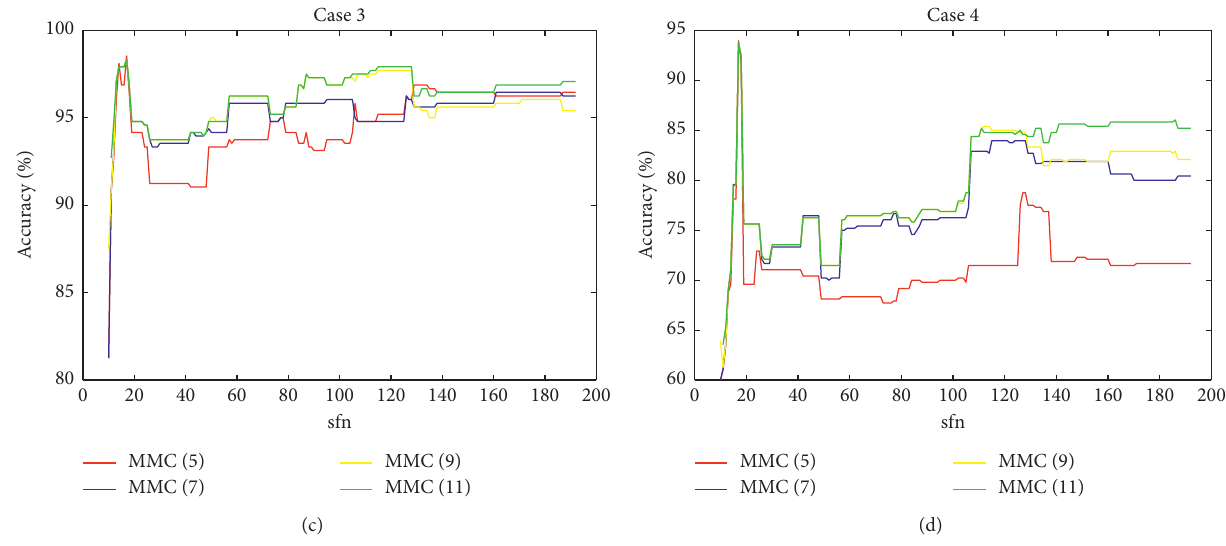
Figure 14: The curve representation of diagnosis results obtained by OFS-TSFRS-MMC-SVM using DTCWPT with different dimension sizes for MMC. The MMC (5) represents that the number of dimension size is